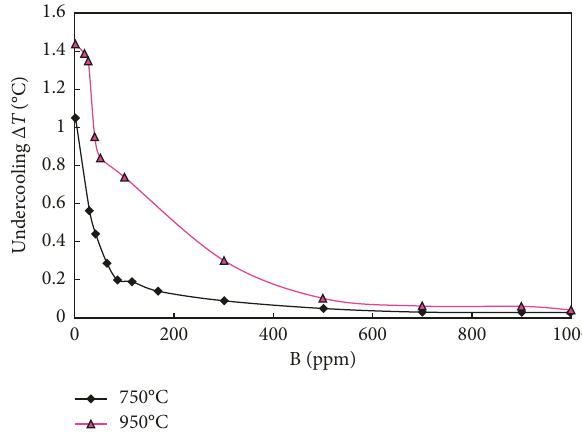
Figure 11: Undercooling measured in the A356.2 alloy as a func- tion of the added B and pouring temperature.